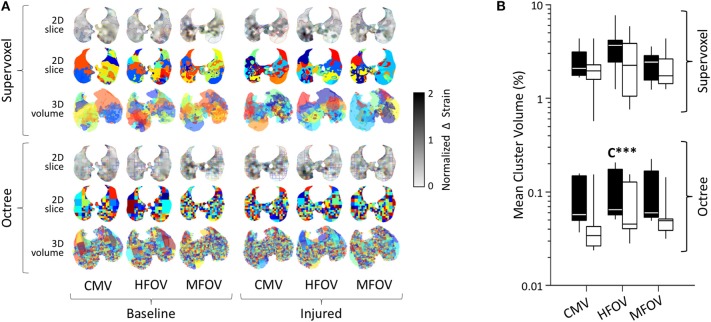
Regional patchiness of intratidal variations in volumetric strain (Δε) during conventional mechanical ventilation (CMV), high-frequency oscillatory ventilation (HFOV), and multi-frequency oscillatory ventilation (MFOV). Regional patchiness was assessed by the size, number, and distribution of regions-of-interest or clusters (randomized colors) obtained by recursive supervoxel or octree decomposition. Examples from a representative subject (A), and cluster volumes as a fraction of the lung mask (B) represented by box plots showing minimum, maximum, and quartiles across subjects under baseline (black) and injured (white) conditions. Asterisks indicate significance levels (***p < 0.001) for main effects (C = lung condition).